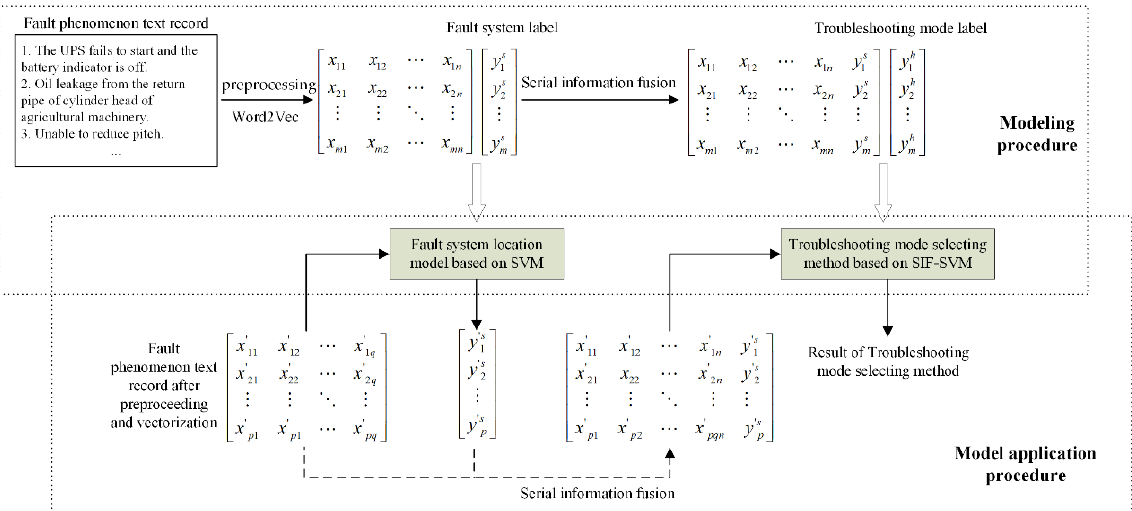
Figure 5. Modeling and application flow of UAV troubleshooting mode selection method based on SIF-SVM.